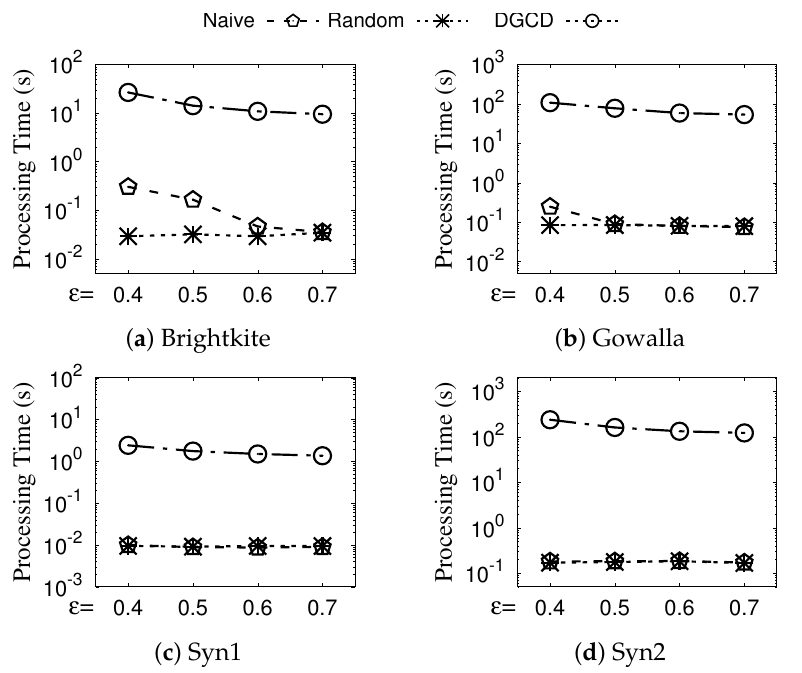
Figure 7. (Eval-III) Against existing algorithms (vary (cid:101) ). Eval-IV: Vary µ . Figure 8 presents the performances of GSGD (with NaiveMCC and Ran- domMCC ) and DGCD by varying µ . Basically, the processing times of both GSGD and DGCD hold steady for different µ values. GSGD takes slightly less time when µ increases. That is because, as µ increase, more vertices can be pruned to be core vertices (see Section 4.1) in our paradigm; thus, less structurally similar computations are found between core vertices along with less time cost. Furthermore, GSGD consistently outperforms DGCD regarding parameter µ